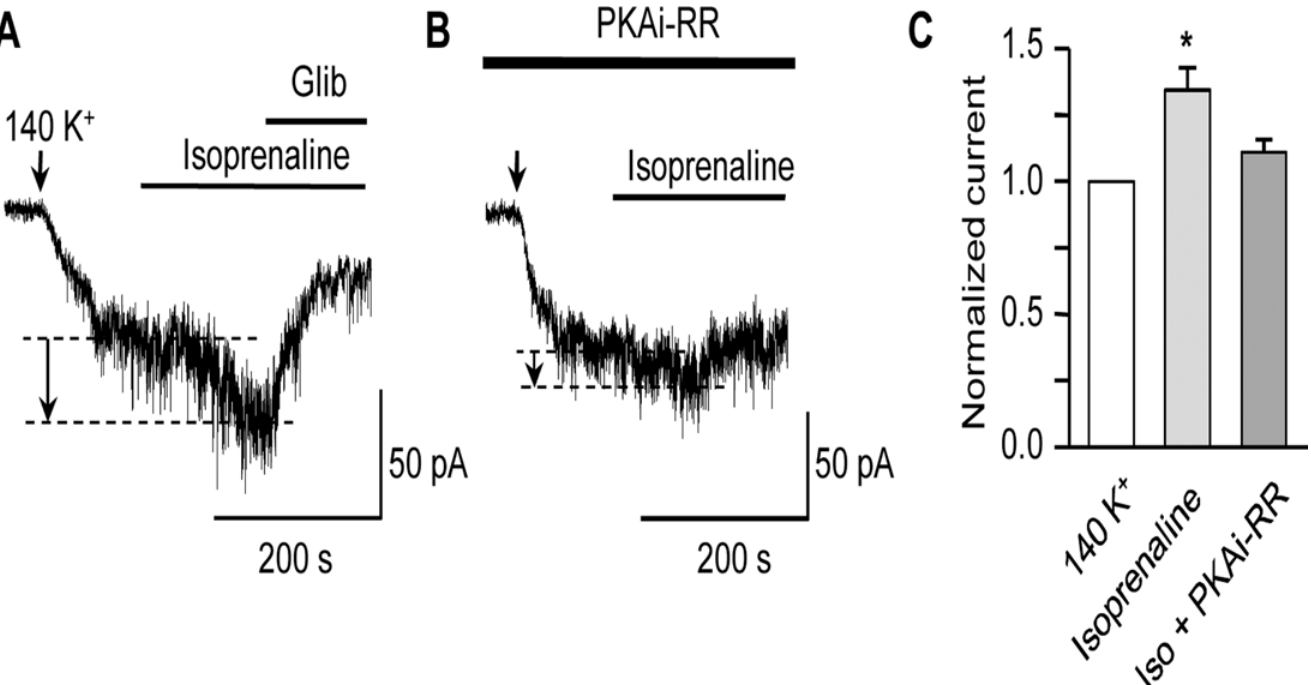
Fig 4. Isoprenaline activates K ATP current in a PKA-dependent manner. Representative K ATP current traces obtained at -60 mV in symmetrical 140 mM K + following the application of isoprenaline (100 nM) in the absence ( A ) or presence ( B ) of the active PKA inhibitor peptide (PKAi-RR, 5 μ M) in the patch- pipette. Arrows in this and subsequent figures indicate the point at which extracellular [K + ] was increased from 6 to 140 mM. The current increase in response to isoprenaline is indicated by the dashed lines and arrows. ( C ) Mean K ATP current, (normalized to that in 140 mM K + ) following the application of 100 nM isoprenaline in the absence (n = 6) or presence (n = 8) of PKAi-RR in the patch-pipette ( * P < 0.05; one-way ANOVA, Bonferroni ’ s post hoc test).